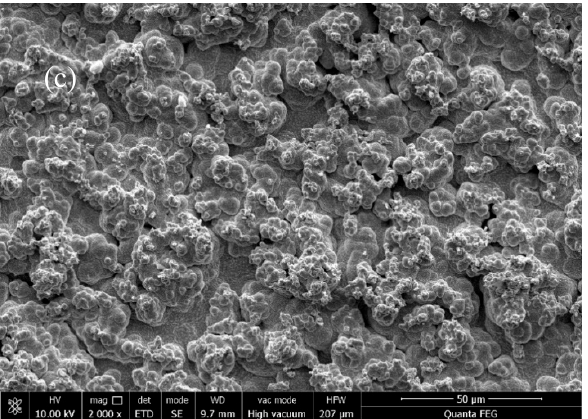
Figure 9. Micrographs of composite coatings prepared by different forward duty cycles (×2000): ( a ) 0.1, ( b ) 0.2, ( c ) 0.3.